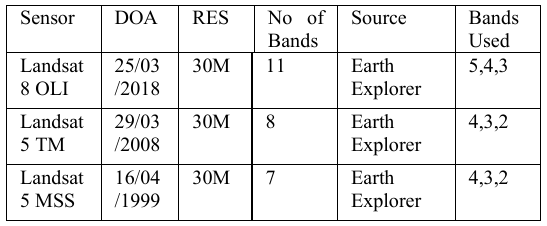
Table 1: Landsat data acquisition